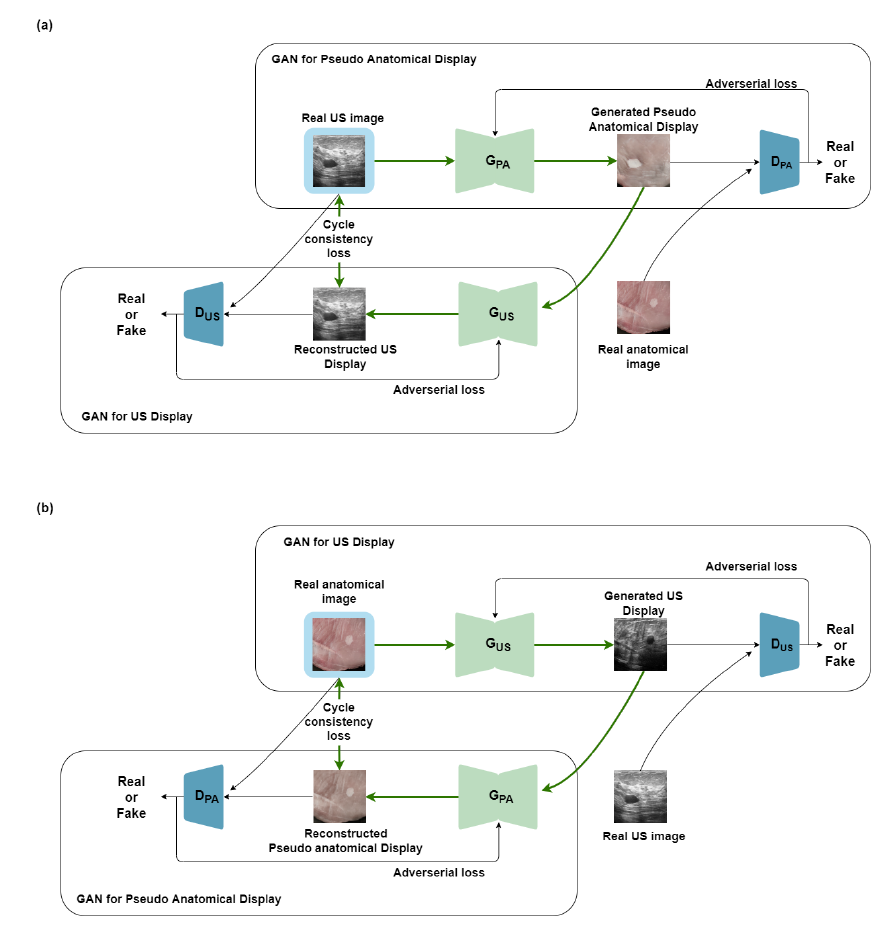
Figure 1. ( a ) Schematic diagram of the CycleGAN model used here to translate real ultrasound images into pseudo anatomical images. The upper block is the GAN for producing the pseudo anatomical display, and the lower block is the GAN for producing the ultrasound display. ( b ) An identical network is used for generating ultrasound displays from anatomical